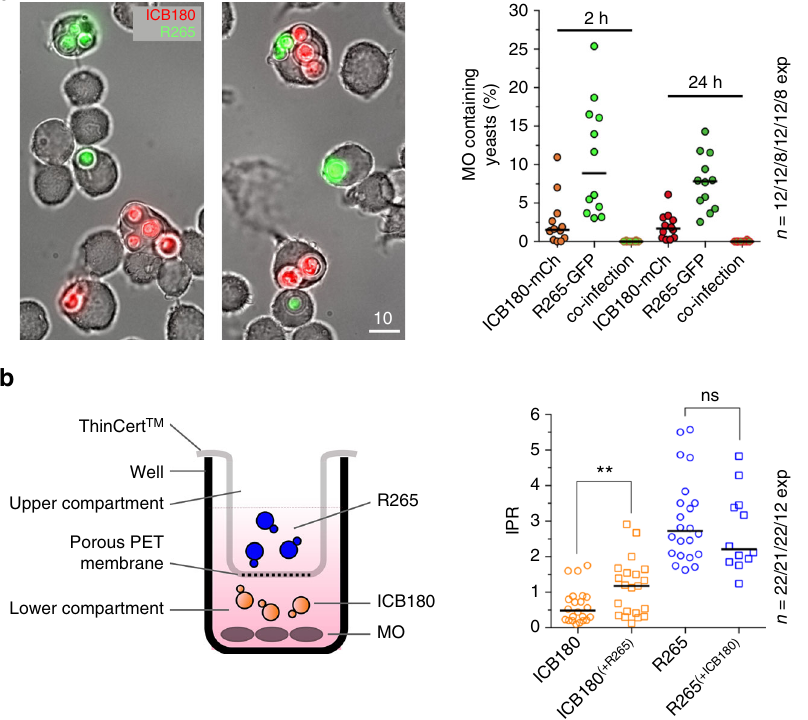
Fig. 1 Long-distance communication can drive rapid intracellular proliferation in C. gattii . a During co-infection, different strains of C. gattii (R265-GFP shown in green; ICB180-mCherry shown in red) are rarely phagocytosed by the same macrophage. Bar: 10 μ m. The number of infected macrophages containing both isolates of yeast at the same time is very low at 2 h.p.i. (2 in total 5479 tested macrophages) and at 24h.p.i (1 in total 3235 tested macrophages). Data are presented as scattered dot plots with lines representing their medians. Data are representative of results from 8 − 12 independent experiments with a minimum of 150 macrophages analysed per sample per experiment. b A schematic representation of the experiment using transwell system ThinCert TM with 400nm porous membrane that separates lower from upper compartments thereby allowing splitting of growth of two different C. gattii strains R265 (pathogenic) and ICB180 (non-pathogenic). After two initial hours of the infection the transwell system was removed and intracellular proliferation rate (IPR) of ICB180 was measured (as T 0 ) and after following 24h (as T 24 ). The 2-h presence of R265 (outbreak) cryptococci in the transwell system (ICB180 ( + R265) ) induces signi fi cantly higher intracellular proliferation of ICB180 (non-outbreak strain) within macrophages ( P = 0.0038, Wilcoxon matched-pairs signed rank test), an effect that is not seen when R265 is replaced for ICB180 (R265 ( + ICB180) ; P = 0.9263, Wilcoxon matched-pairs signed rank test). Data are presented as scattered dot plots with lines representing their medians. Data are representative of results from 12 – 22 independent experiments with 879 – 5238 total yeasts counted for each sample. Wilcoxon matched-pairs signed rank test where ** ( P ≤ 0.01), signi fi cant difference; ns ( P > 0.05), not